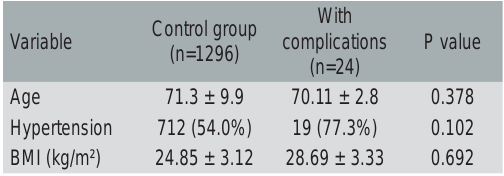
TABLE 1. Risk factors associated with complications